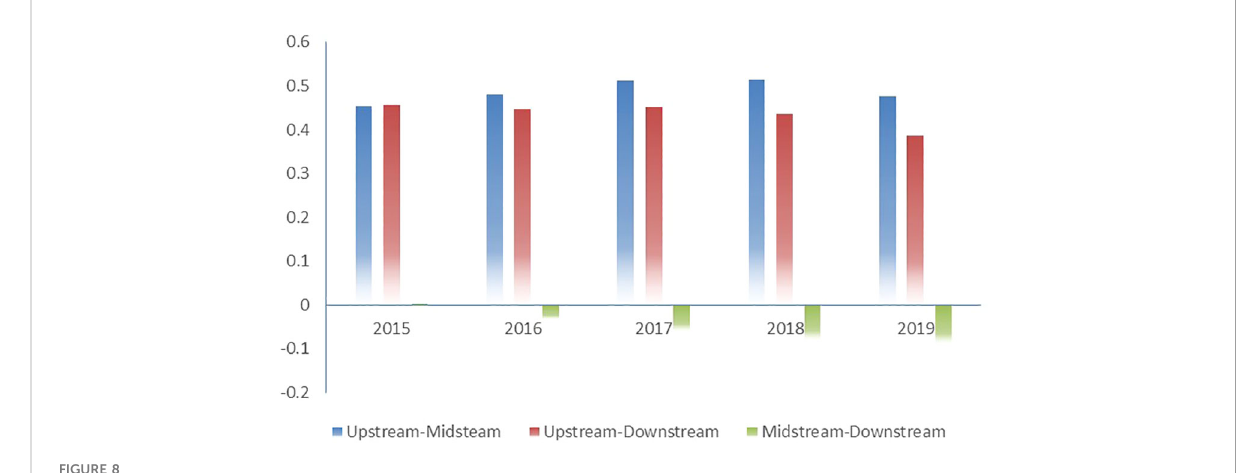
FIGURE 8 Technology gap between industry chain links after adjustment, 2015-2019.